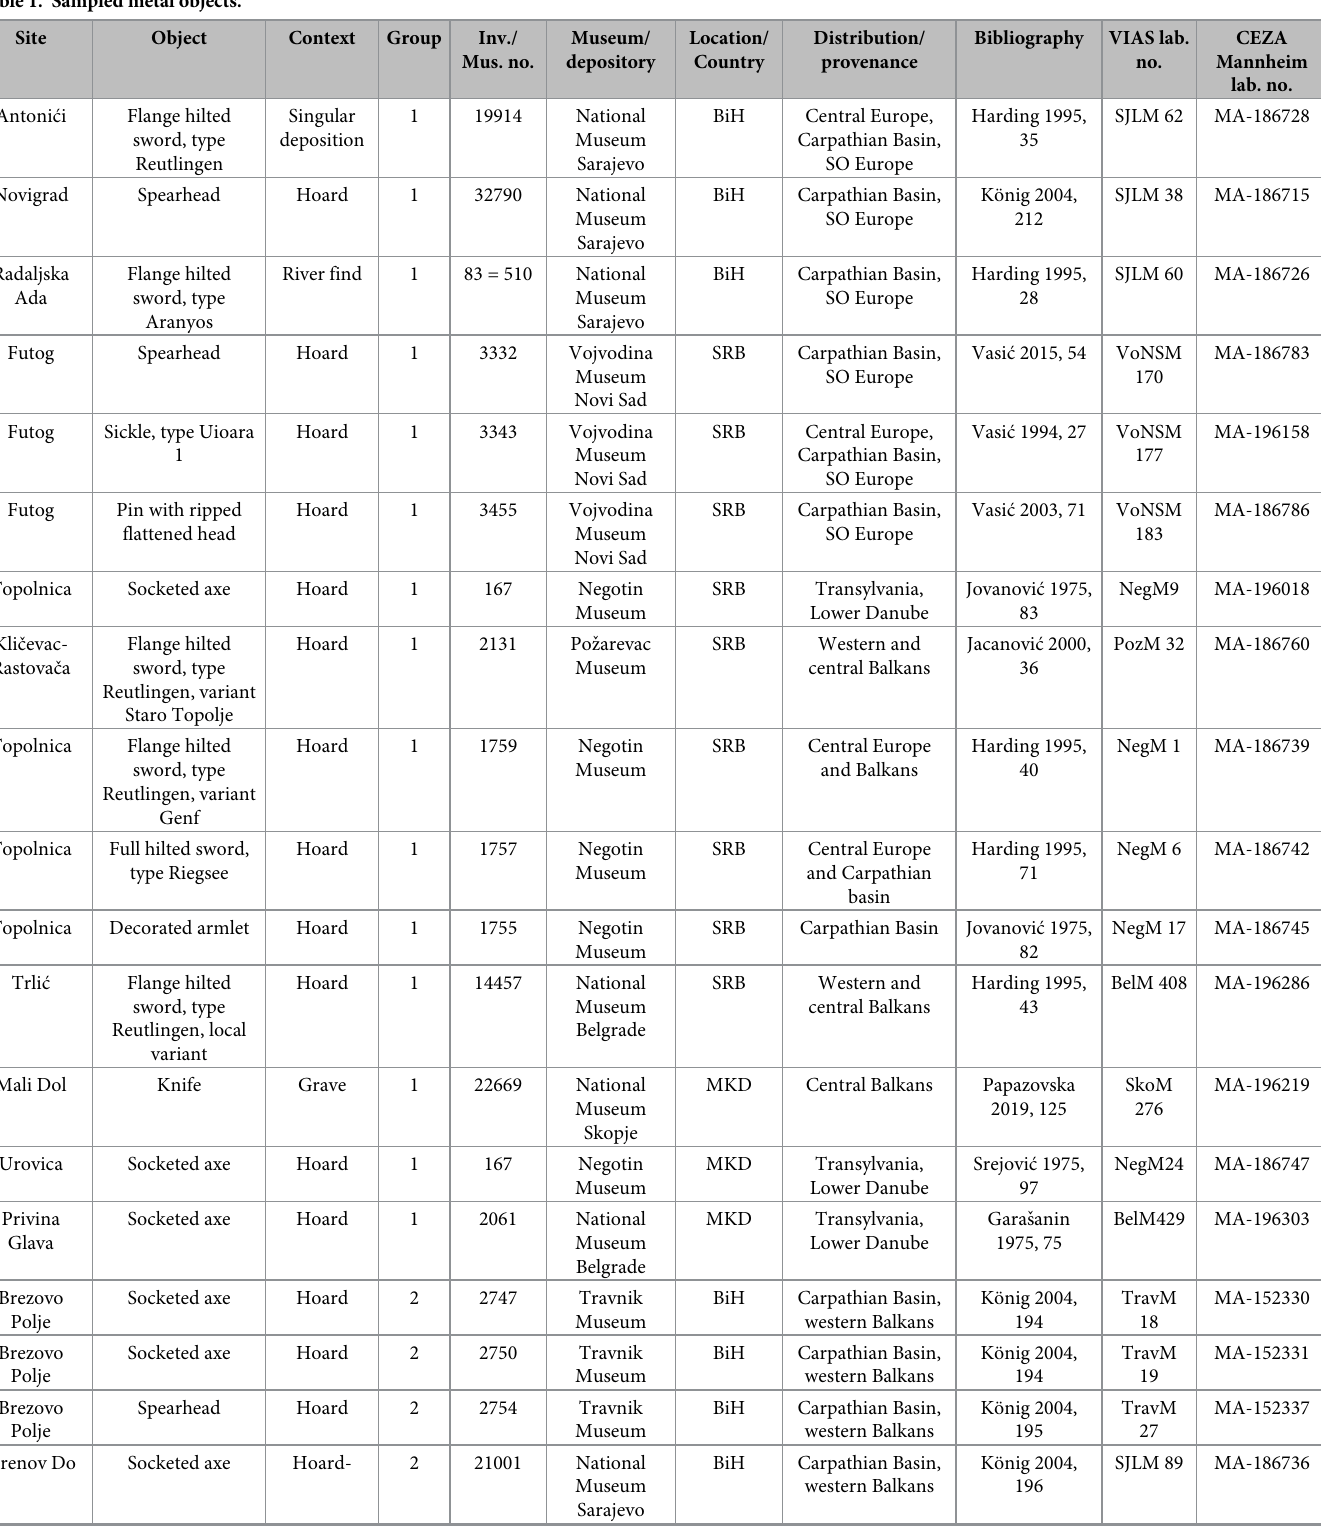
Table 1. Sampled metal